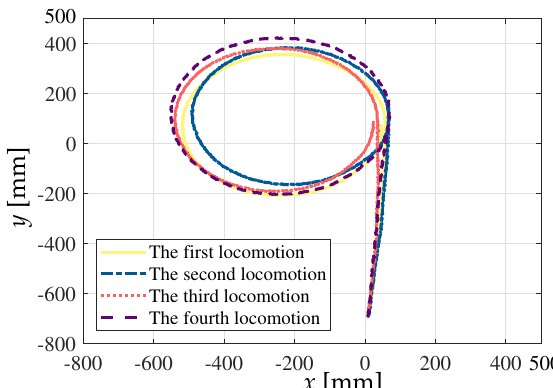
Figure 9. Four trajectories of the parallel-connected SWC robots in the